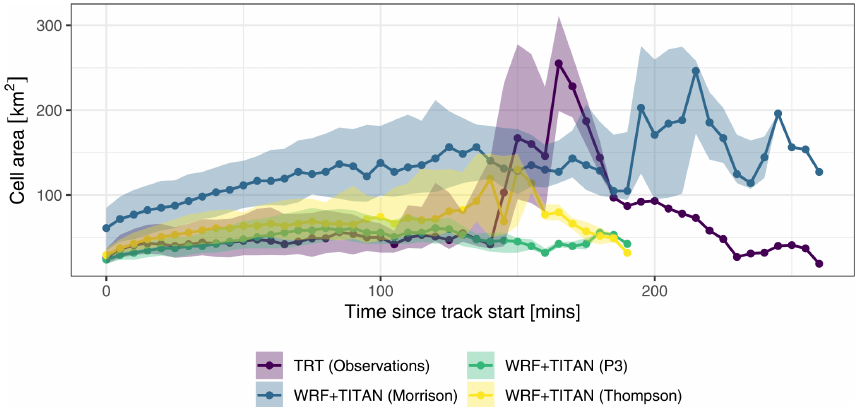
Figure 13. Area development over cell life cycles for observations and simulation outputs. For each time since the track start, the coloured band shows the interquartile range of area and the joined points show the median area.